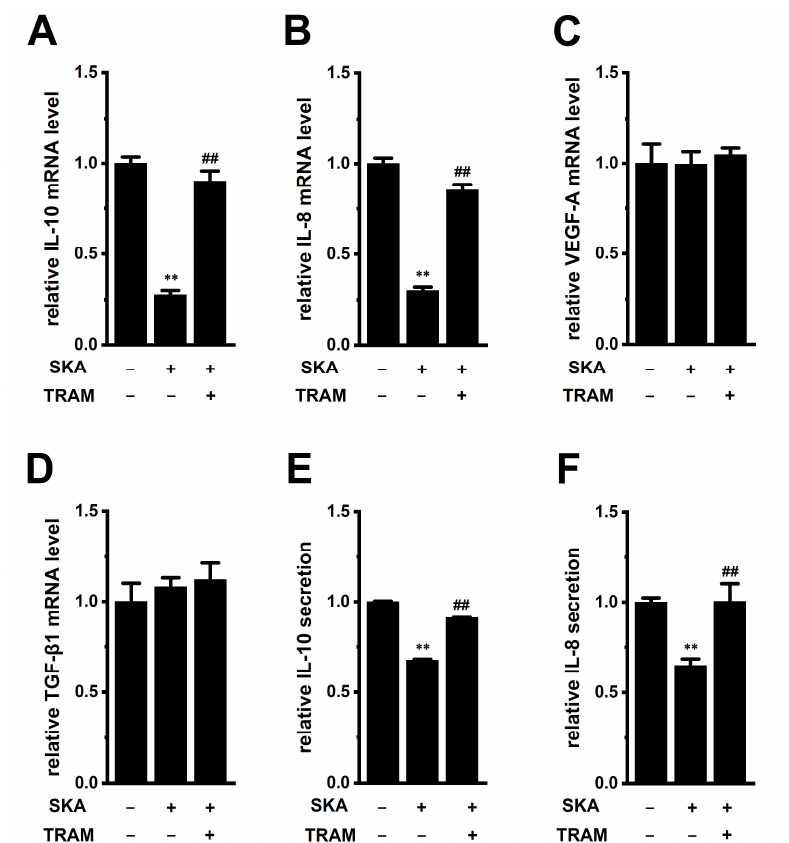
Figure 4. Effects of treatment with SKA-121 on IL-10, IL-8, VEGF-A, and TGF- β 1 expression and on IL-10 and IL-8 secretion in THP-1-derived M 2 macrophages. A–D: Real-time PCR examination of IL-10 ( A ), IL-8 ( B ), VEGF-A ( C ), and TGF- β 1 ( D ) expression in THP-1-derived M 2 macrophages treated (+) or untreated ( − ) with 1 µ M SKA-121 and 10 µ M TRAM-34 for 24 h. Relative mRNA expression in the vehicle control (‘ − ’ for SKA and ‘ − ’ for TRAM) is expressed as 1.0 (n = 4 for each). ( E , F ): Quantitative detection of IL-10 ( E ) and IL-8 ( F ) secretion by an ELISA assay in THP-1-derived M 2 macrophages treated and untreated with SKA-121 and TRAM-34. Relative cytokine secretion in the vehicle control ( − / − ) is expressed as 1.0 (n = 4 for each). **: p < 0.01 vs. the vehicle control ( − / − ), ## : p < 0.01 vs. SKA-121 alone (+/−).